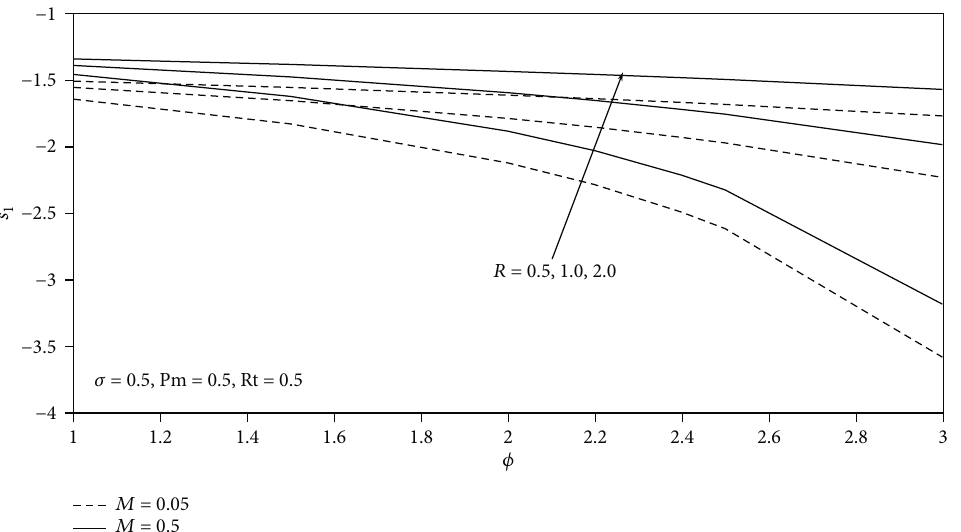
ϕ for di ff erent values of M and R . 1 Þ versus